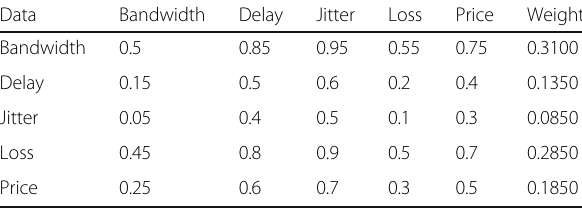
Table 9 Fuzzy consistent matrix and weights for data application Data